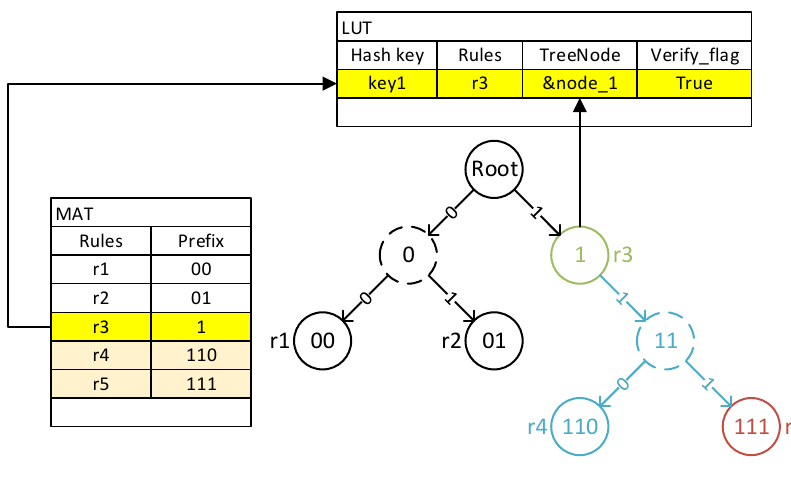
Figure 7. LUT design for LPM